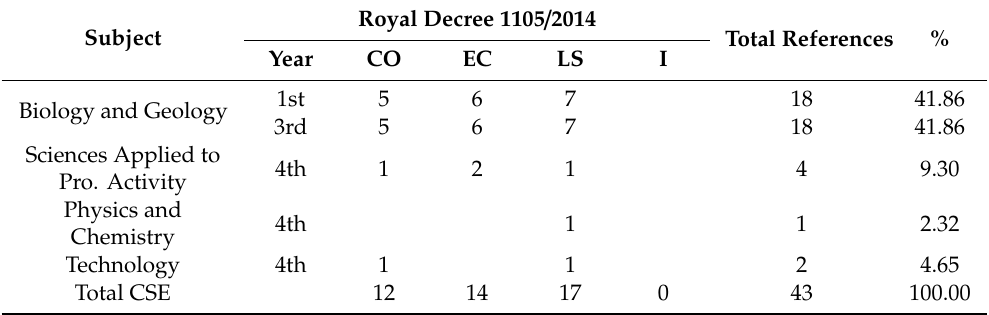
Table 2. Number of occasions in which the concept of water appears and percentage in the di ff erent subjects in the study plan of CSE. Abbreviations: Contents (CO), Evaluation Criteria (EC), Learning Standards (LS) and Introduction